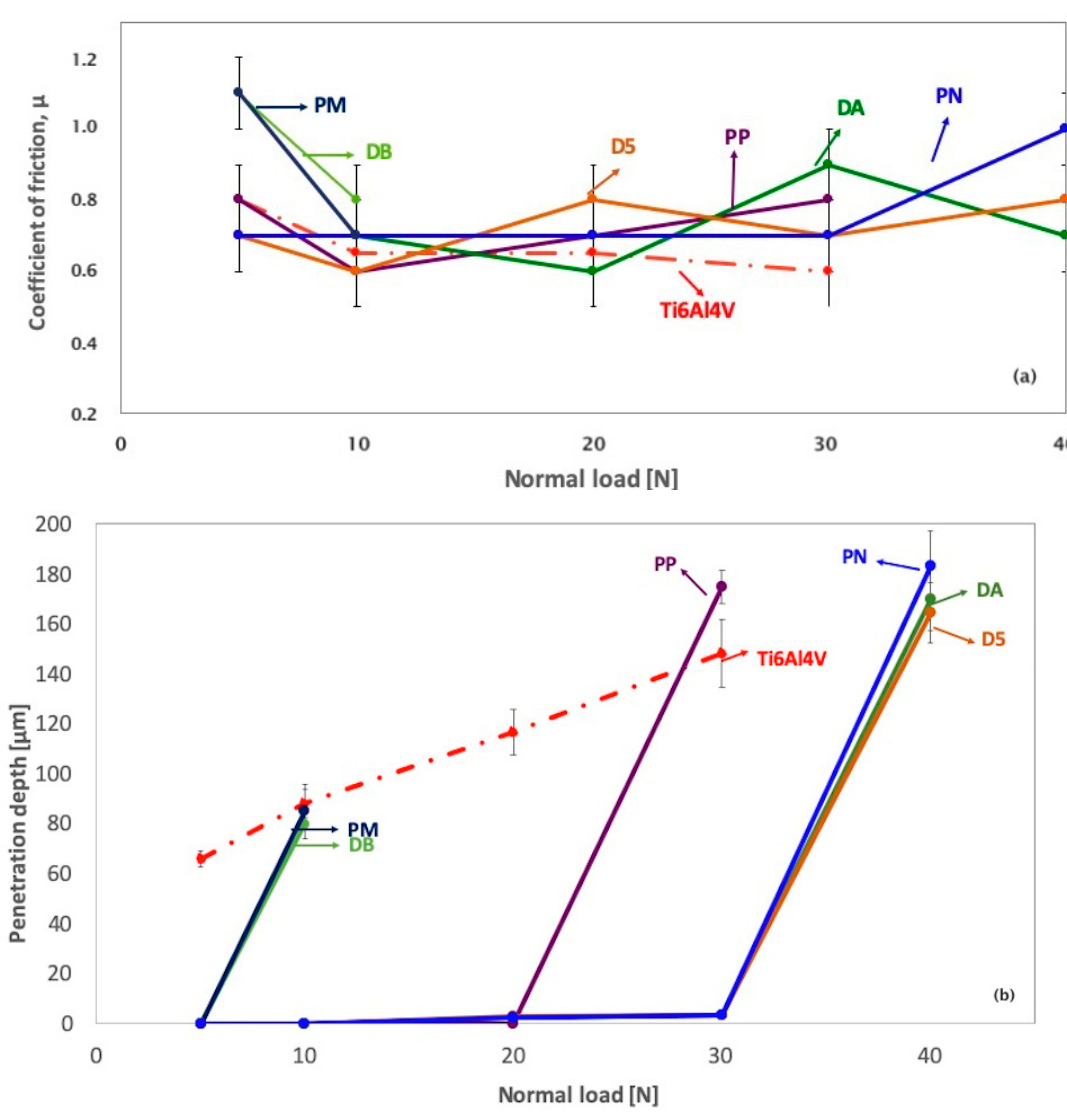
Figure 7. Average values of coefficient of friction ( a ) and maximum wear depth on blocks ( b ) as a function of normal load. In ( a ), the trend line for PM overlaps the one for DA between 5 and 10 N.